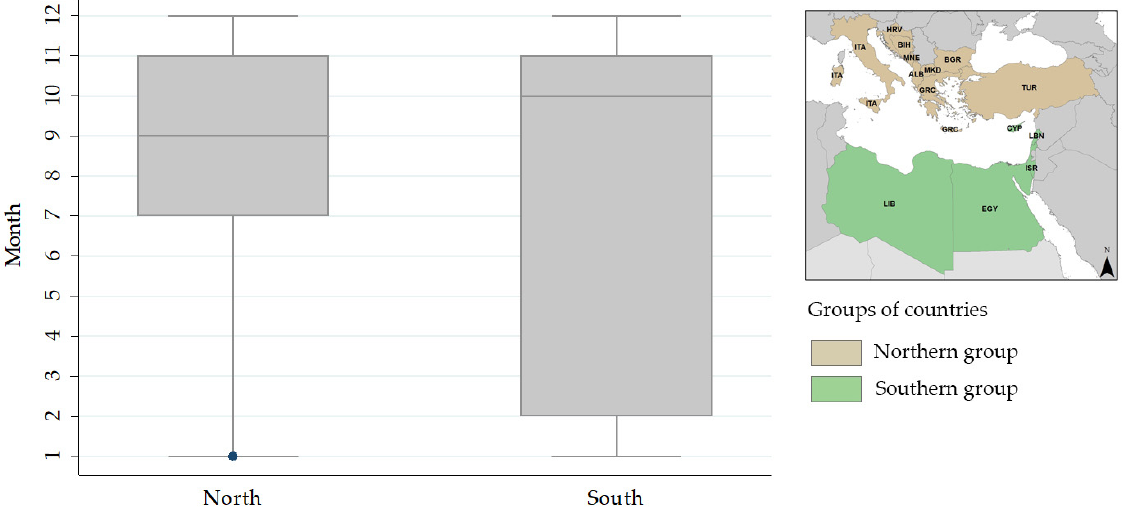
Figure 10. Distribution (boxplot) of monthly occurrences over two geographical regions of the study area: northern (ITA, ALB, BIH, BGR, GRC, MKD, HRV, MNE, TUR) and southern (CYP, EGY, ISR, LBN, LBY), along with a map illustrating the separation of regions. Blue dots represent outlier events.